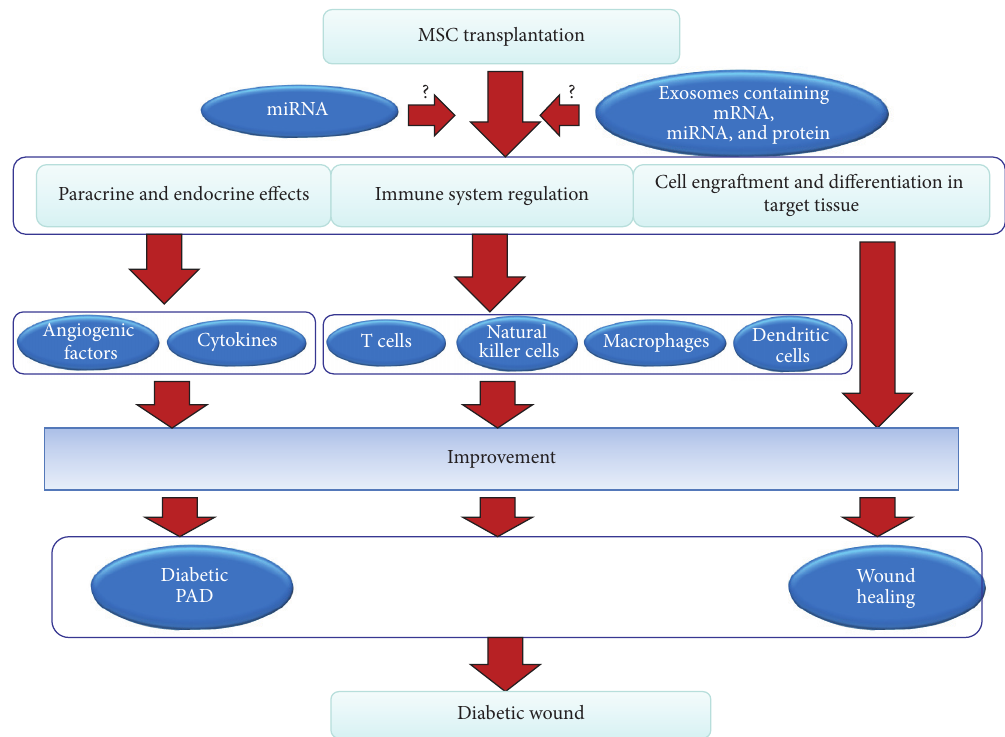
Figure 2: Mechanism of the effect of transplantation of MSCs on diabetic wound. The mechanism of diabetic wound recovery by MSC transplantation stems from three pathways: the first is the secretion of angiogenic and factors and cytokines, the second is regulation of the immune system, and the third is the engraftment and differentiation of the cells into tissue constituents. Stem cells can specifically improve the local secretion and expression of angiogenic factors and cytokines, which contributes to the improvement of diabetic PAD and diabetes itself. Stem cells can also regulate the activities of T cells, natural killer cells, macrophages, and dendritic cells and can inhibit infections and inflammatory reactions. Moreover, MSCs can differentiate into target tissues to achieve a reparative effect. These effects may be associated with miRNA and